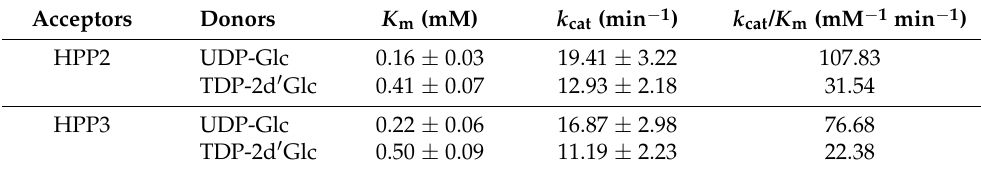
Table 1. Kinetic parameters for a recombinant StSPGT with both SP aglycone acceptors (HPP2 and HPP3) and two glycosyl donors (uridine diphosphate-glucose [UDP-Glc] and thymidine diphosphate- 2 (cid:48) -deoxy-glucose [TDP-2 (cid:48)